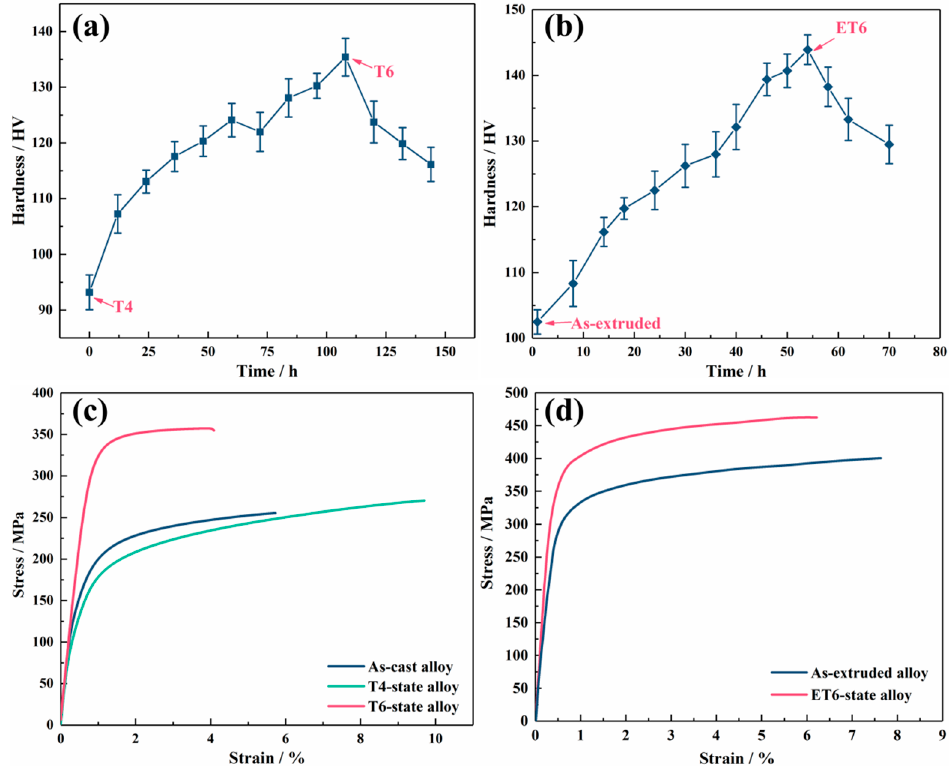
Figure 2. Age hardening curves of ( a ) T4 and ( b ) as-extruded alloys under 200 °C; ( c , d ) tensile stress–strain curves of EQ142X alloys with different states. Table 3. Mechanical properties of EQ142X alloys with di ff erent states.